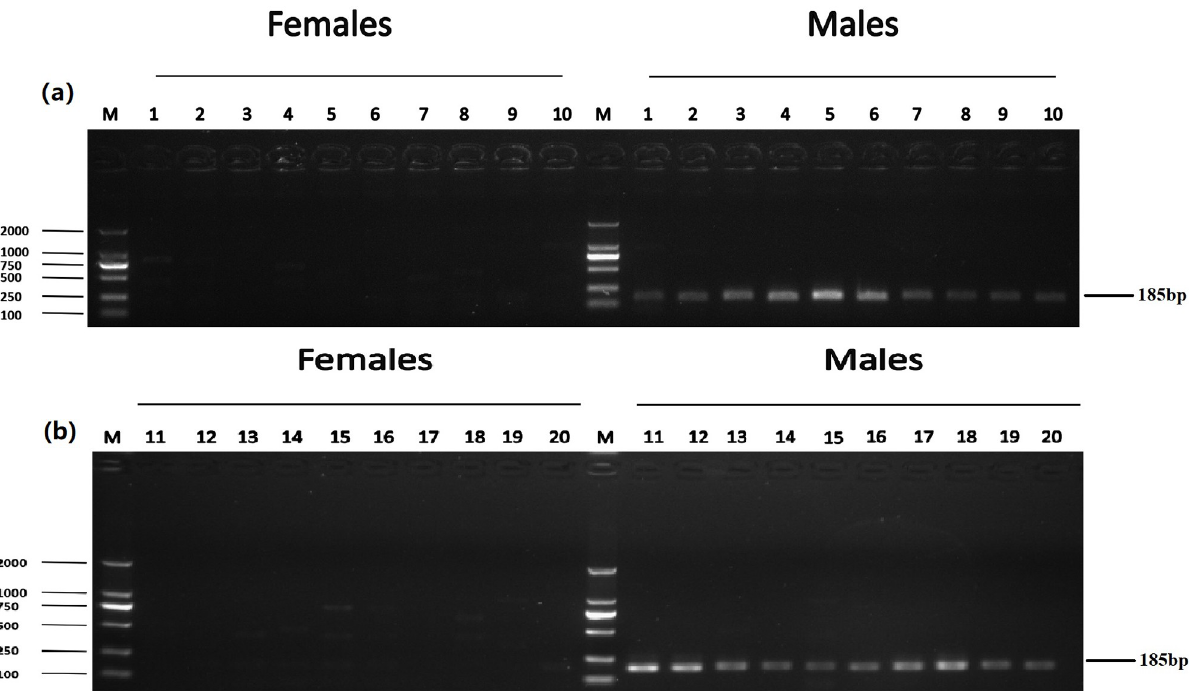
Fig 5. Identification of a male-specific tag, DNA fragment, amplified with Tag8821742. The left shows DL 2000 DNA marker sizes; the right shows fragment sizes.